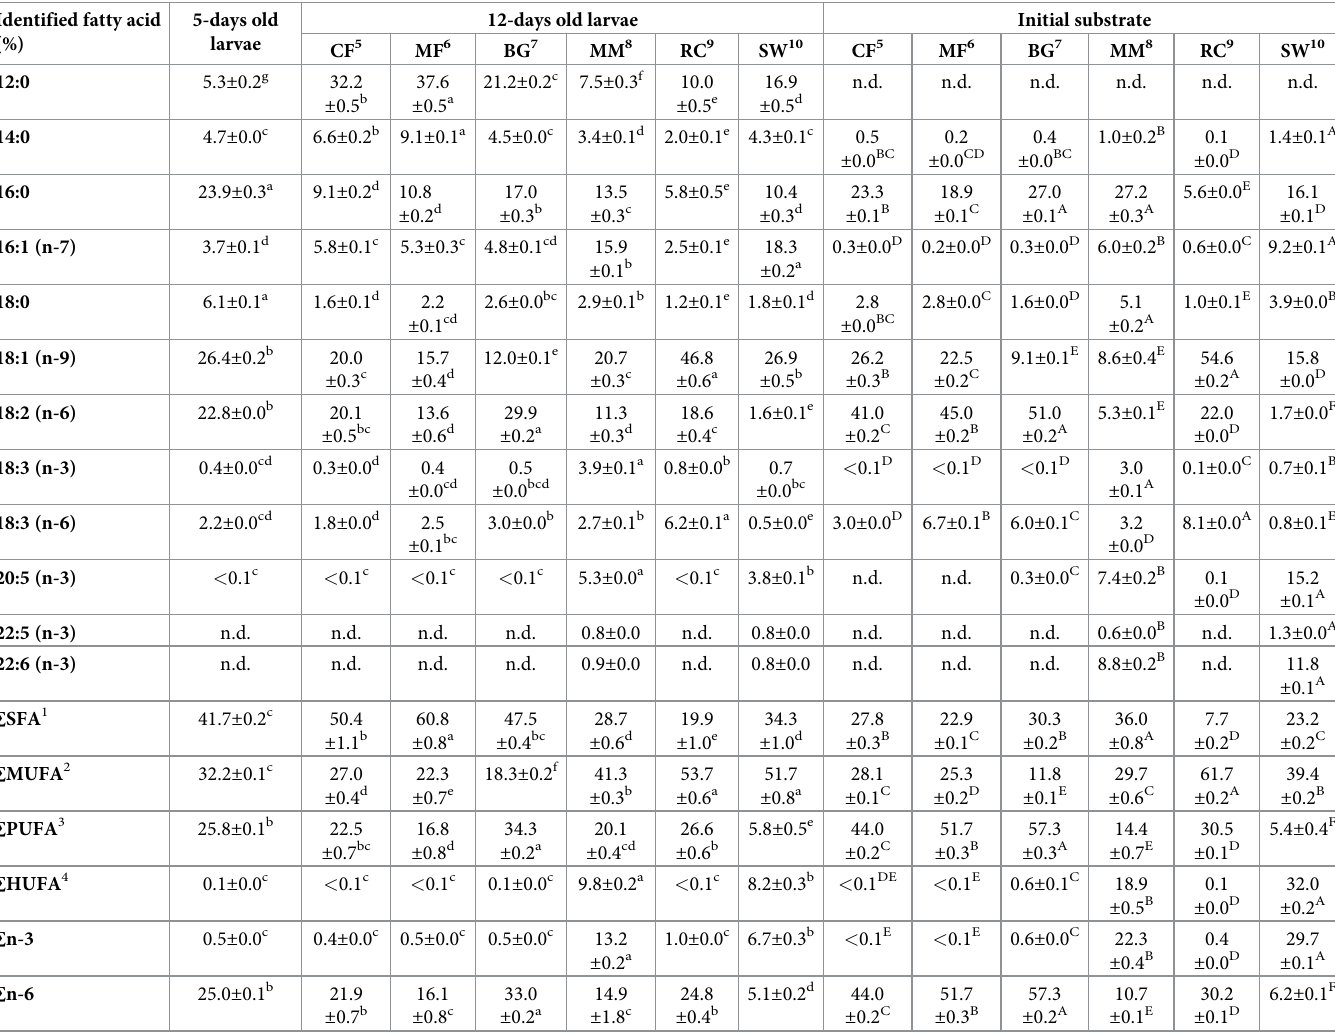
Table 5. Fatty acid composition of black soldier fly larvae at the start (5-days old larvae) and the end (12-days old larvae) of the trial after feeding different rearing substrates for 7 days, as well as of the initial substrates. All values are expressed relative to the total identified fatty acids and shown as mean ± standard error (SE; n = 3), n.d. = not detected. Dissimilar lower case superscript letters represent significant differences between means within the same row for larvae data and capital super- script letters represent significant differences between means within the same row for initial substrate data (p < 0.05). Identified fatty acid